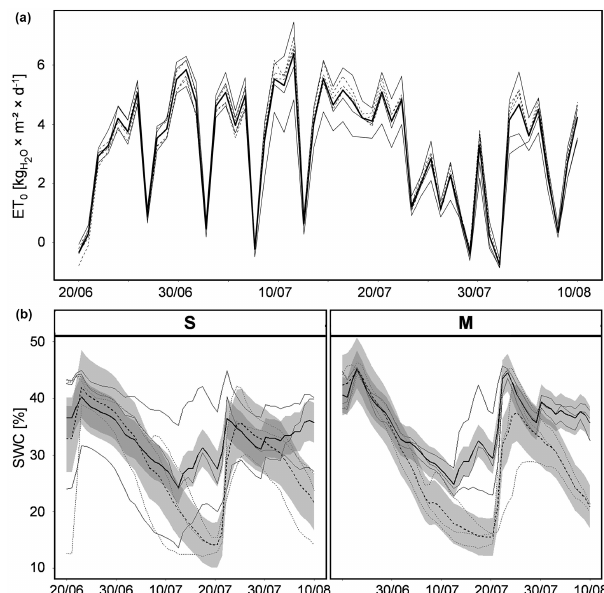
Figure 2. Atmospheric demand (ET 0 ) and SWC as drivers of ET: (a) dynamics of daily average ET 0 over the course of the experi- ment (bold line: all-plot average; thin lines: individual plots); (b) dynamics of daily average SWC for two vegetation types (S and M; see Table 1) in contrasting irrigation schemes (REG – solid lines; D – dashed lines; bold lines: treatment average; shaded area: standard deviation; thin lines: individual plots); S: Stubai; M: Matsch/Mazia.